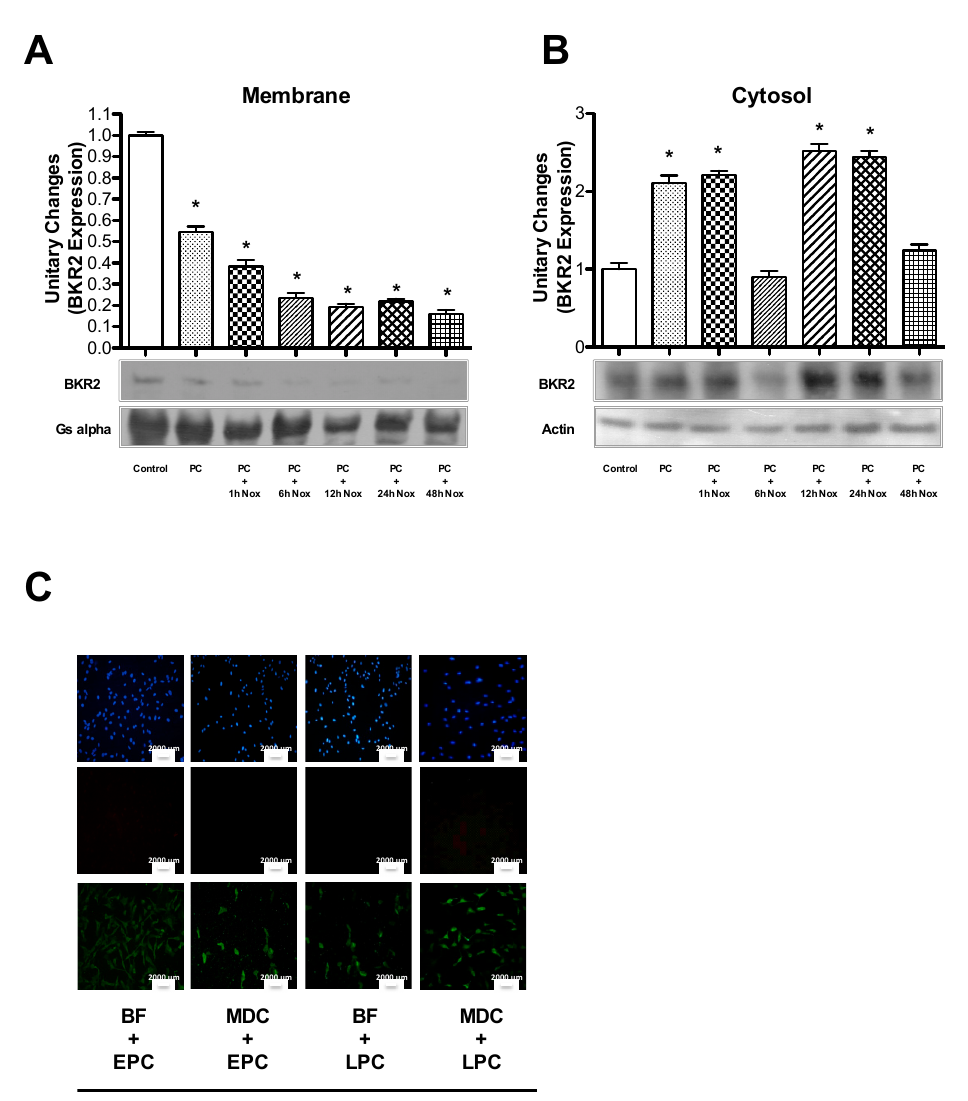
Figure 4. Cells were subjected to preconditioning (PC). Membrane (50 µ g) ( A ) and cytosolic (50 µ g) ( B ) fractions were subjected to immunoblot analyses using anti-BKR2 antibody. The bar graph represents densitometric analysis, with the mean ± SEM, expressed as fold increase / decrease in protein translocation over that in control cells, of three independent experiments. ( C ) Cells were subjected to prolonged hypoxia (12 h) after early and late preconditioning (EPC and LPC), in the absence and presence of selective clathrin (monodansylcadaverine) and lysosomal vacuolar ATPase (bafilomycin) inhibitors, as reported in the text. Cells were stained with Annexin-V (green), Propidium Iodide (PI, red) and DAPI. The rates of apoptosis and necrosis were calculated by dividing the number of Annexin-V-positive / PI-negative cells and Annexin-V-positive / PI-positive cells, respectively, by the total number of nuclei detected with DAPI staining. The percentage of apoptotic and necrotic cell death was calculated from four independent experiments. Quantification of apoptosis and necrosis is reported in Table S2 of Supplementary Material. The size of the scale bar is 2000 µ m. Nox: normoxia; BKR2: bradykinin receptor 2; BF: bafilomycin; MDC: monodansylcadaverine. * p < 0.001 vs. control, by one-way ANOVA with a post hoc test of HSD. These findings indicate that the recycling and endocytosis of BKR2 are required for the PC-induced cytoprotective effect.